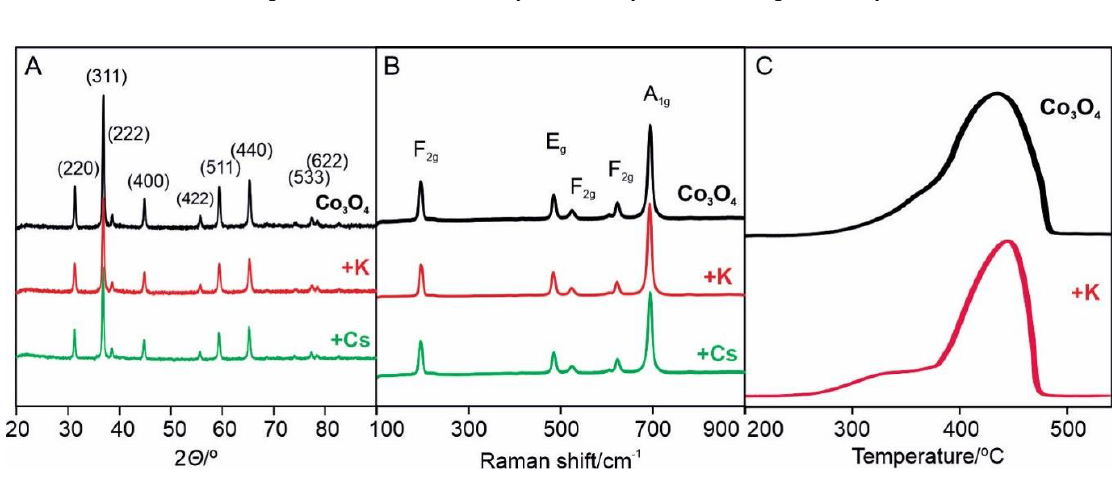
Figure 4. Physicochemical characterization of surface promoted cobalt spinel catalysts by X-ray diffraction (XRD) ( A ), Raman Spectroscopy ( B ) and temperature programmed reduction (TPR) ( C ) techniques.